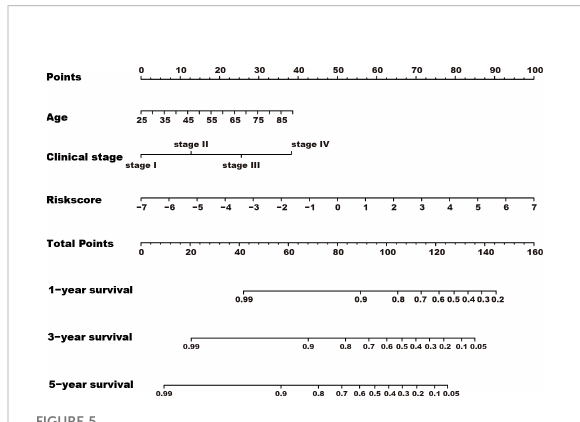
FIGURE 5 A nomogram was constructed for predicting the overall survival of kidney cancer patients. TRGs risk score, clinical stage, and age composed the nomogram using the total TCGA cohort, and the risk score has the most contribution to the total points.